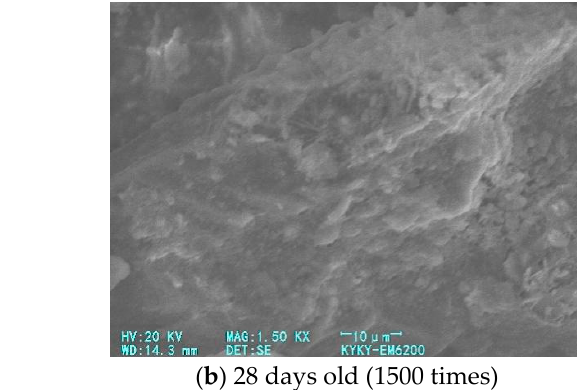
Figure 10. SEM pictures of fiber FA cement–soil at different